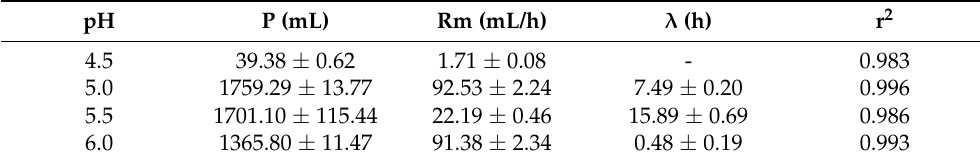
Table 3. Kinetic parameters of hydrogen production estimated using the modified Gompertz